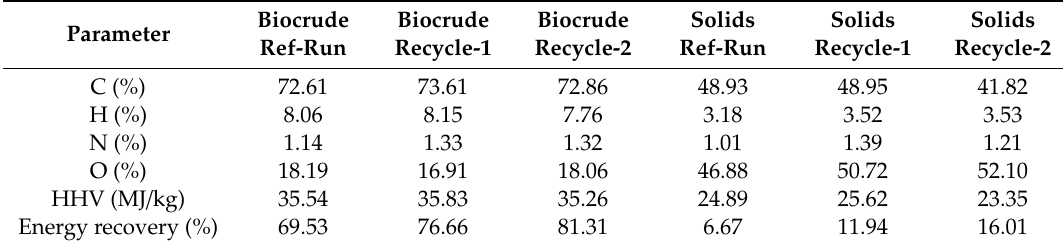
Table 6. Elemental composition, HHVs, and energy recoveries of biocrude and solid residue after aqueous phase